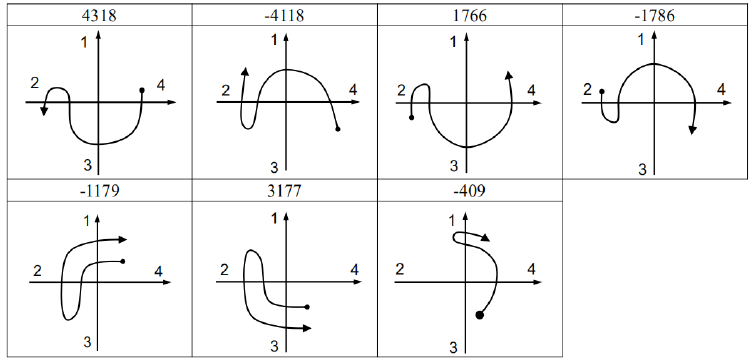
Figure A2. Code templates and sketch maps of down gesture.